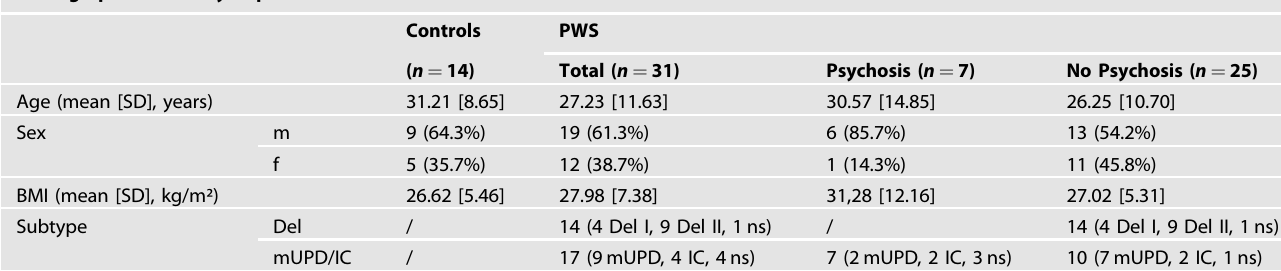
Table 1. Demographic